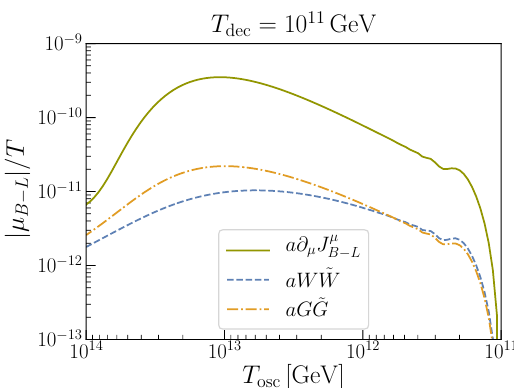
Figure 6 . The (cid:12)nal B L asymmetry produced for di(cid:11)erent values of the axion oscillation tem- (cid:0) perature T osc . The axion decay temperature is taken as T dec = 10 11